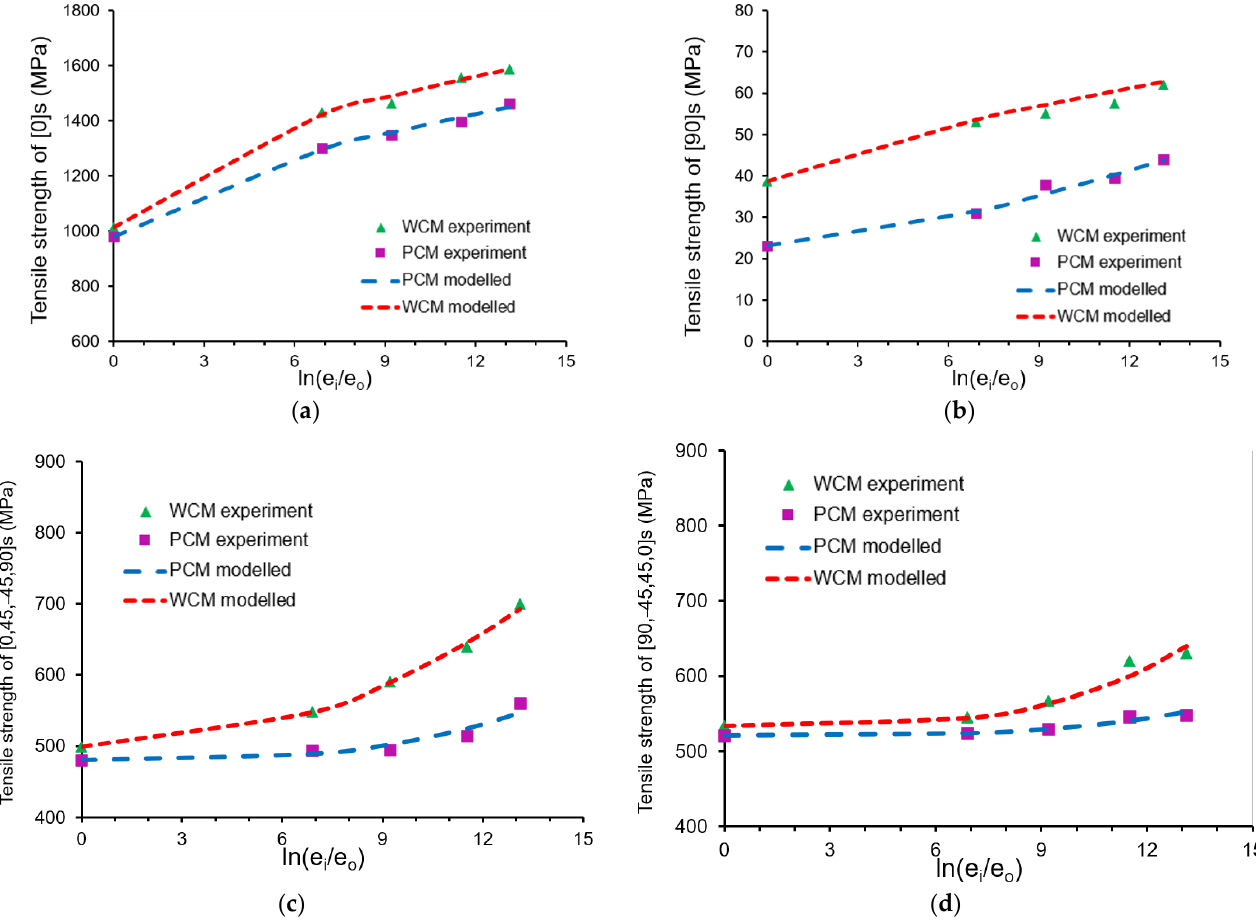
Figure 7. Effect of strain rate on tensile strength of different configurations: ( a ) (0)s; ( b ) (90)s; ( c ) [0/45/−45/90]s; ( d ) [90/−45/45/0]s.